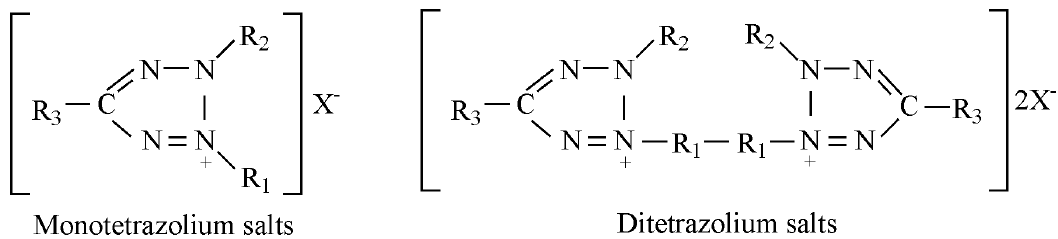
Fig. 1 Structure of mono- and ditetrazolium salts deriving from